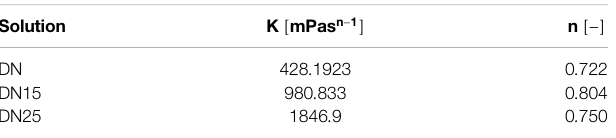
TABLE 2| Rheological parametersofDN hydrogelsolutionswithdifferentglycerol concentrations. Consistency (K) and power law (n) indices were obtained through curve fi tting.